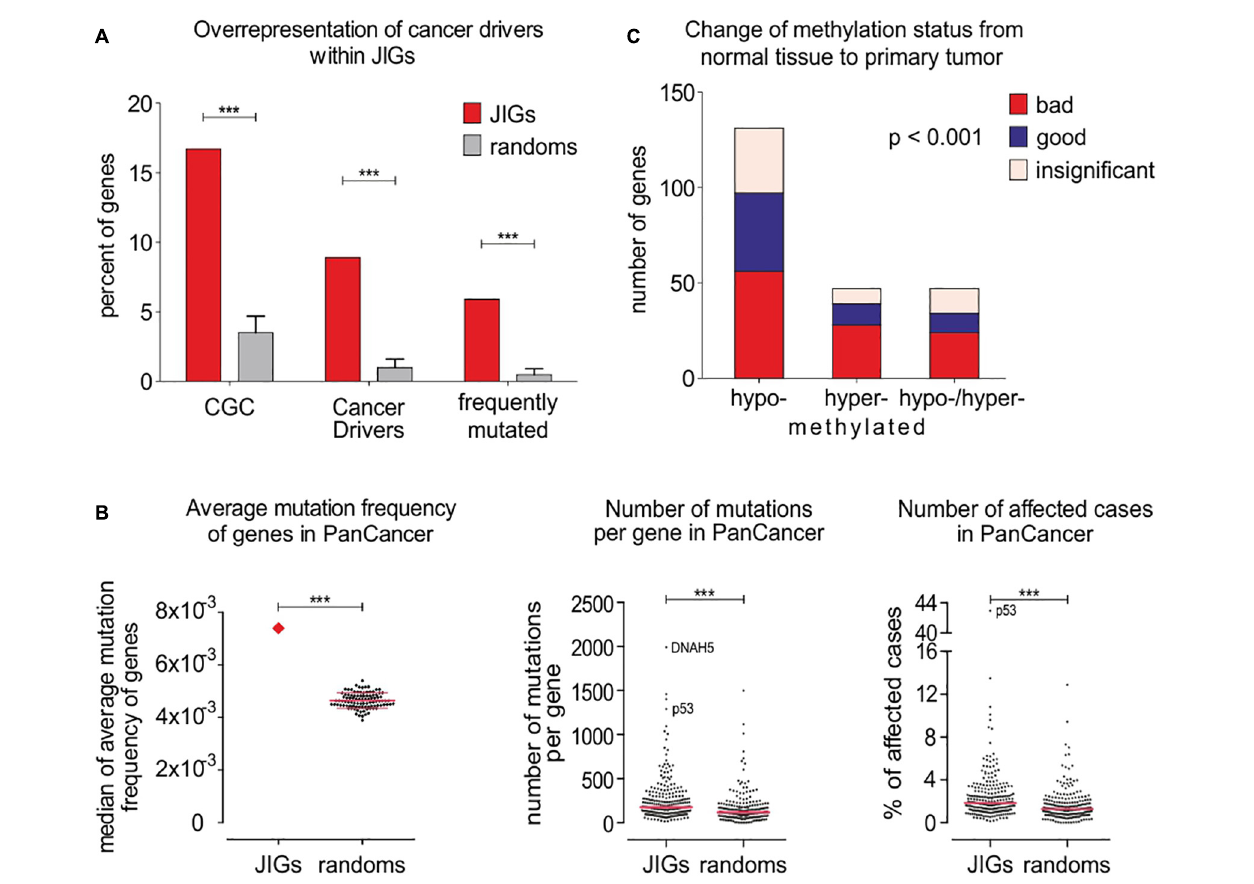
FIGURE 4 | JIGs undergo frequent gene mutations and epigenetic alterations across cancer types. (A) JIG enrichments in known and frequently mutated cancer drivers as indicated versus controls were 16.7% vs. 3.5 ± 1.2% ( p < 0.001), (left) ; 8.9% vs. 1.0 ± 0.6% ( p < 0.001), (middle) ; and 5.9% vs. 0.5 ± 0.4% ( p < 0.001), (right) . (B) The average mutation frequency of JIGs is higher in PanCan cohort versus genes of the random lists (left) . This entails a higher number of mutations per individual JIG (center) and a higher number of patients exhibiting mutations in JIGs (right) . Pink lines: medians. (C) Almost 74% (225/305) of JIGs undergo aberrant DNA methylation in 42 cancer types versus normal control tissues, whereby 131 are significantly hypomethylated, 47 are hypermethylated, and 47 are either hypomethylated or hypermethylated in a cancer type-dependent manner. Cox regression analysis on PanCan TCGA cohort data showed that more hypo- than hyper- methylated JIGs are correlated with either poor (“bad,” red color) or favorable (“good,” blue color) patient outcomes. Bars represent SEM.